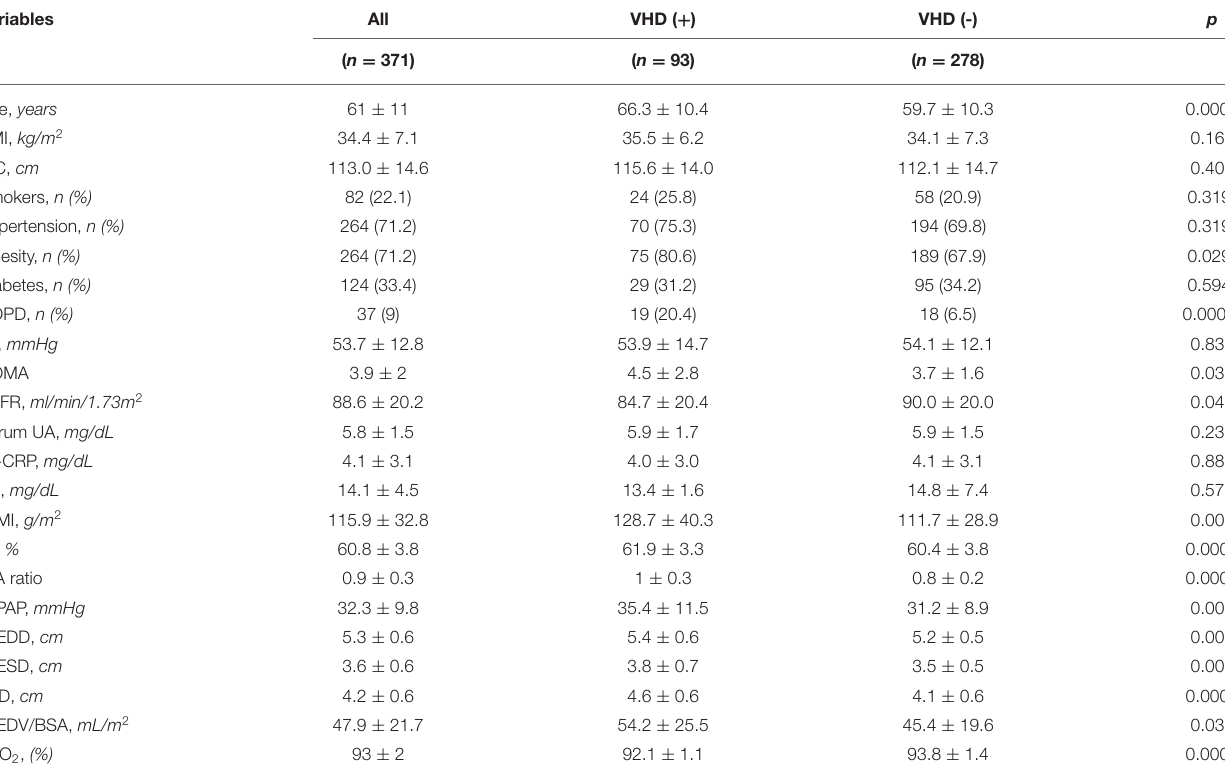
TABLE 3 | Anthropometric, biohumoral and echocardiographic characteristics of SA patients, with or without VHD.